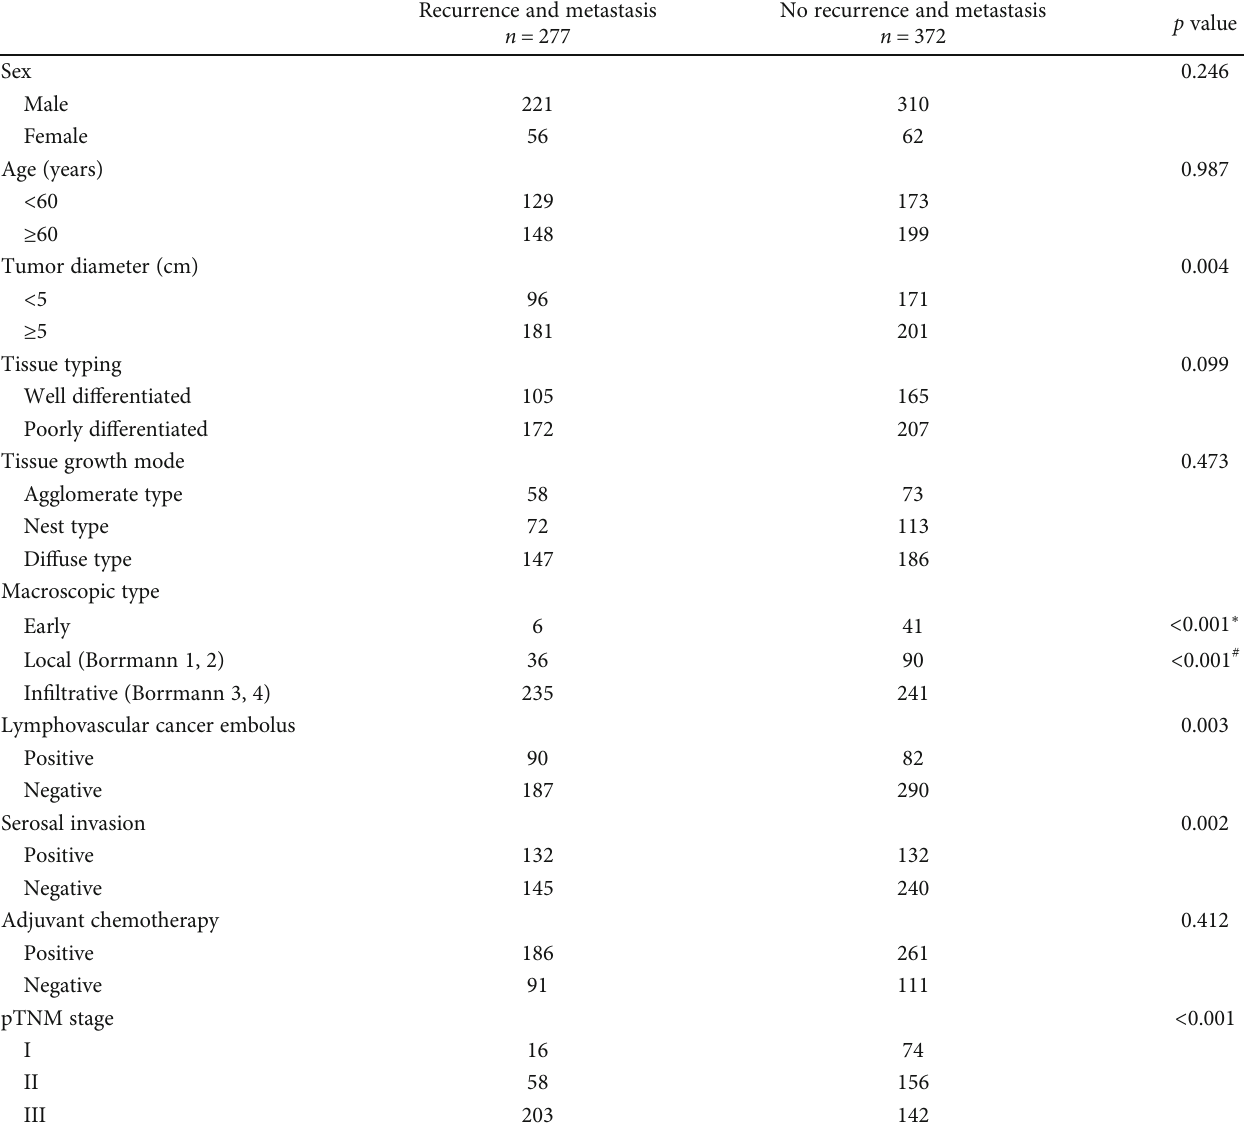
Table 5: Patient characteristics and recurrence and metastasis of upper gastric cancer.